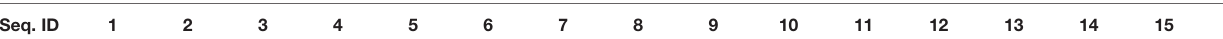
TABLE 4 | Genetic distances between sequences of the 28S rDNA D1-D2 region of Kareniaceae species. Seq.